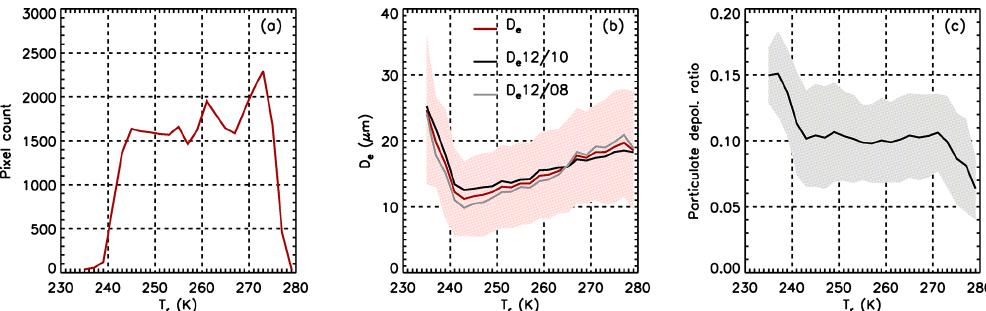
Figure 16. IIR confident retrievals vs. radiative temperature in ST liquid water clouds of centroid altitude > 4km over oceans between 60 ◦ S and 60 ◦ N in January 2008. (a) Pixel count; (b) mean D e (red), D e 12 / 10 (black) and D e 12 / 08 (gray); (c) mean CALIOP integrated particulate depolarization ratio. The shaded areas in panels (b) and (c) represent mean ± mean absolute